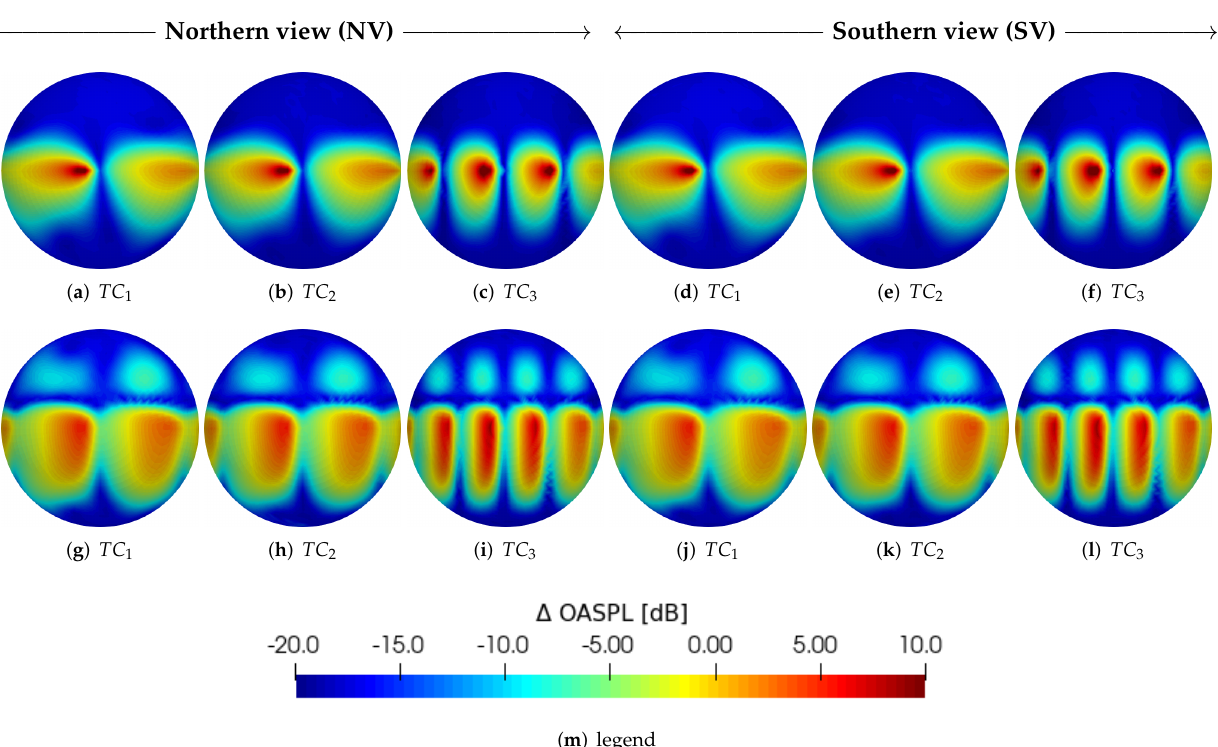
Figure 8. Counter-rotating configuration, difference between far-field and near-field OASPL for the defined TCs and for M t = 0.52 (upper) and M t = 0.7 (lower).